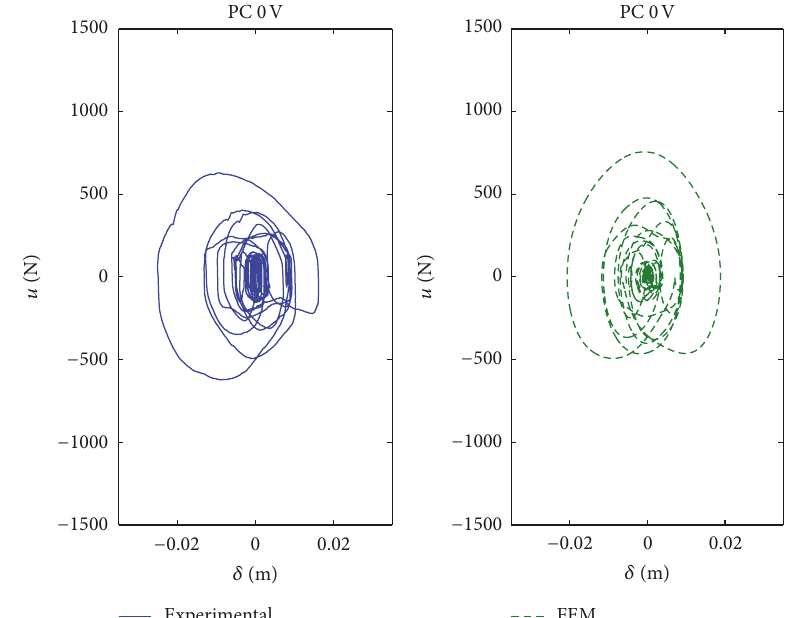
Figure 13: Passive connected (PC) configuration, experimental versus FEM force-displacement, loop voltage level 0V. Kobe test PGA 0.5 g.